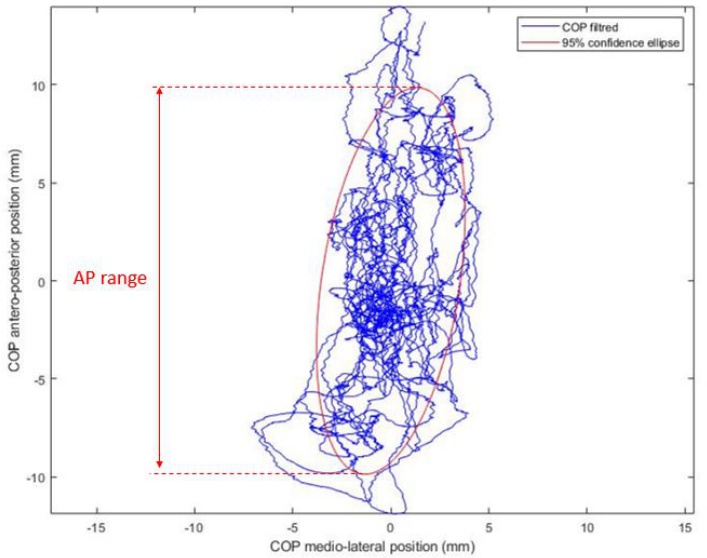
Figure 3. The 95% confidence ellipse of the global COP for the subject 9 in the Ref configuration with OE.